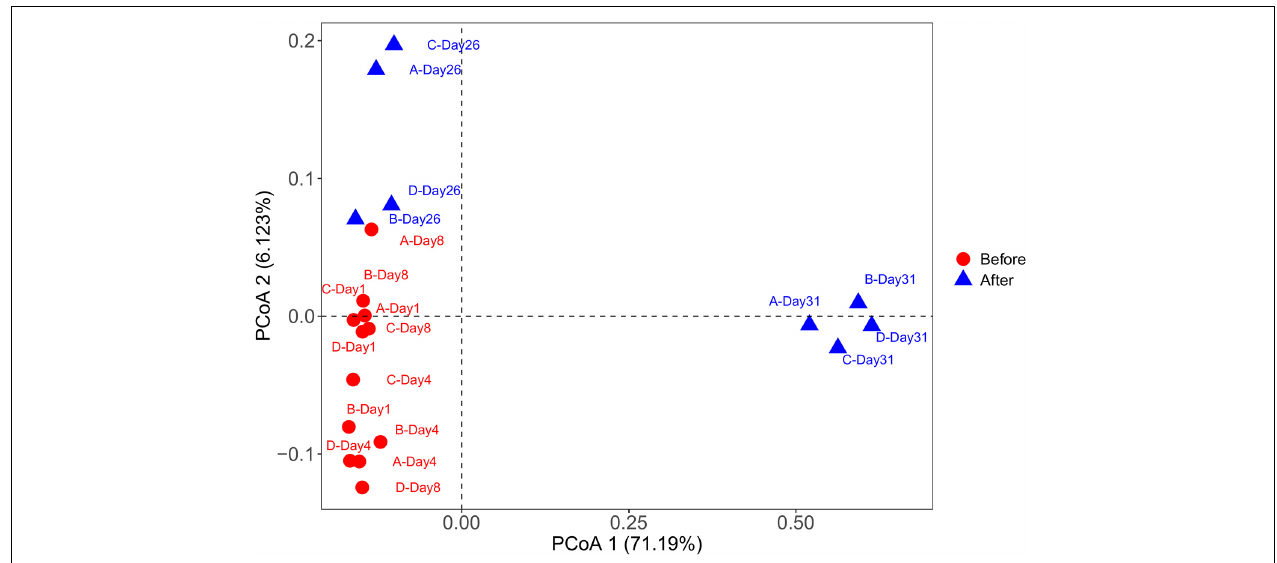
FIGURE 4 | Principal coordinate analysis (PCoA) of microbial communities from cryoconite samples based on Bray-Curtis distance. The PCoA plot showed clear segregation between the before and after snowfall samples.